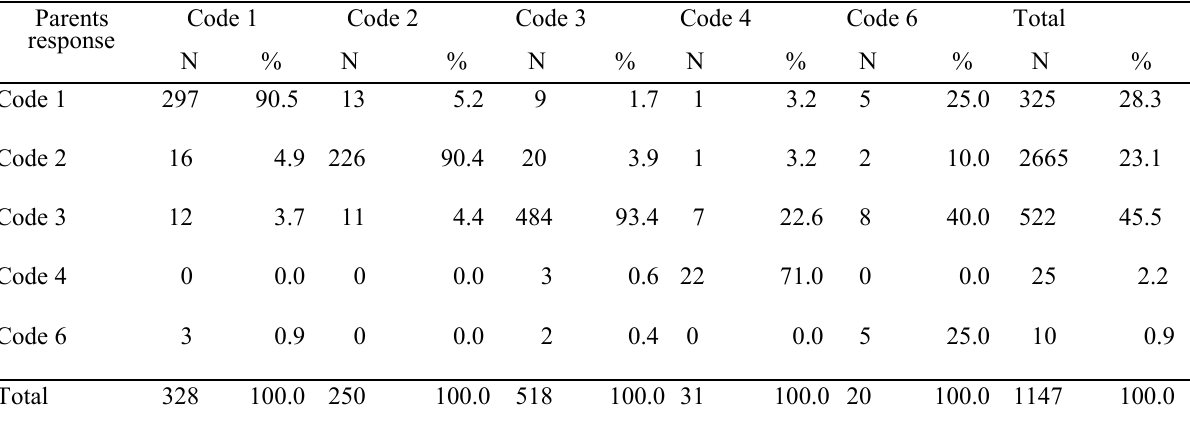
Table 2 Agreement between parents' and adolescents' responses about father's occupation status